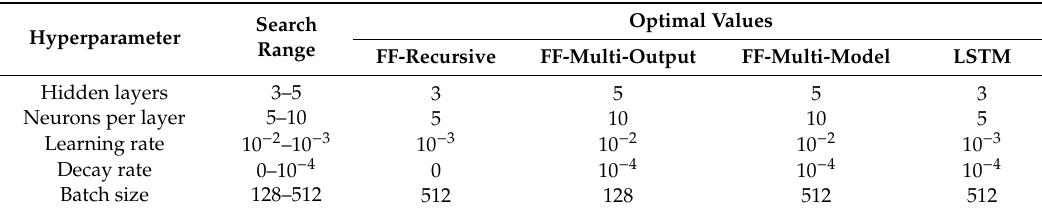
Table 6. Hyperparameters values considered in the grid-search tuning process for FF and LSTM predictors.